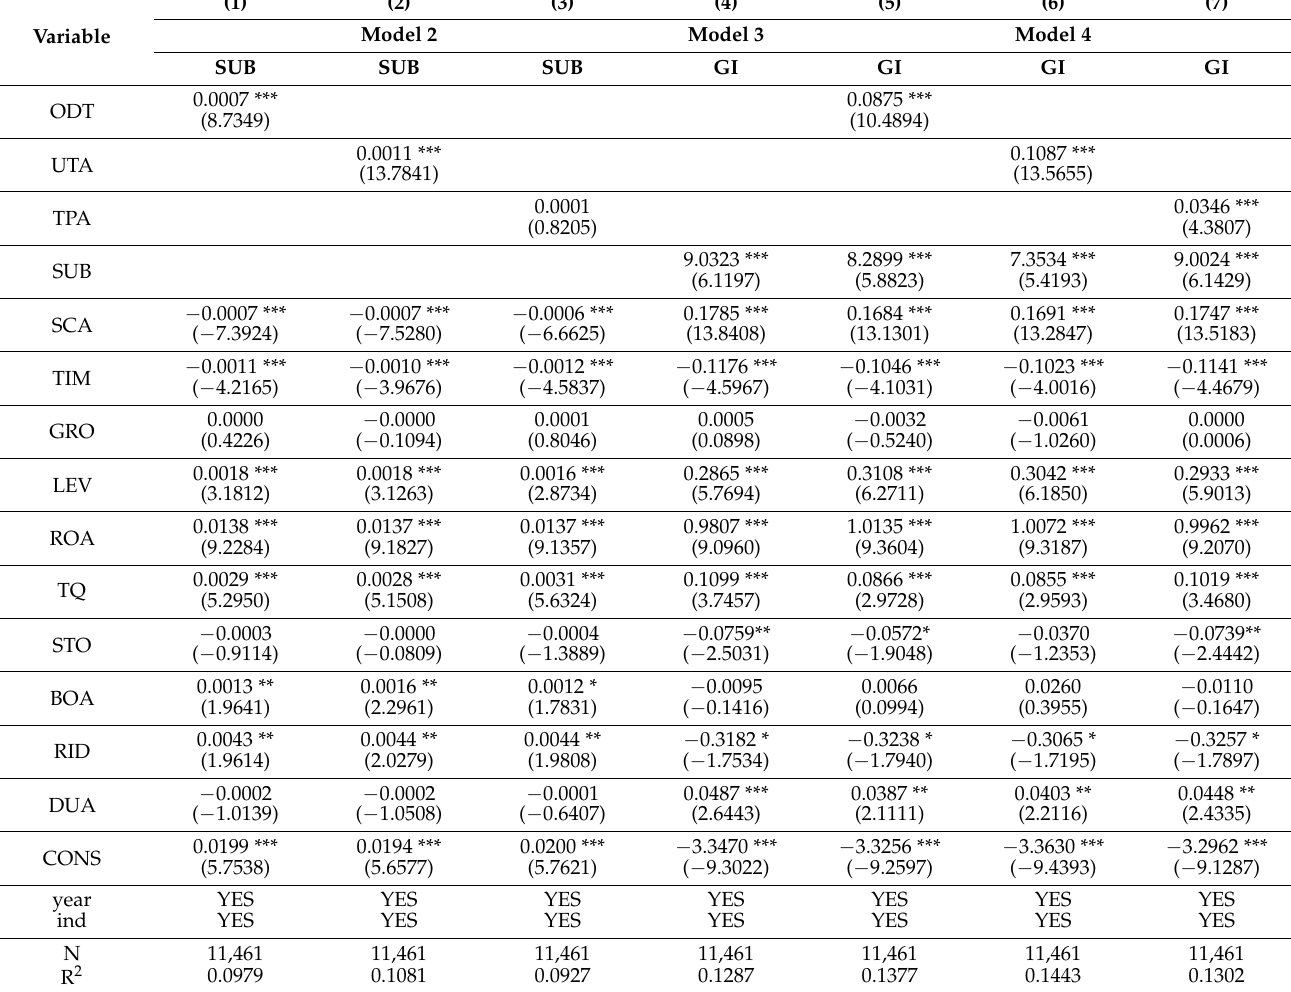
Table 5. Test results of transmission mechanism of government